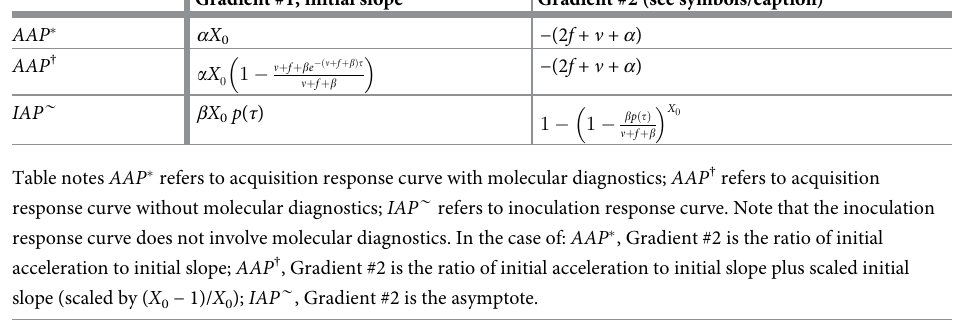
Table 1. Formulae for gradients of access period response curves. All formulae are derived from equations for acqui- sition and inoculation response curves in S4 Appendix.